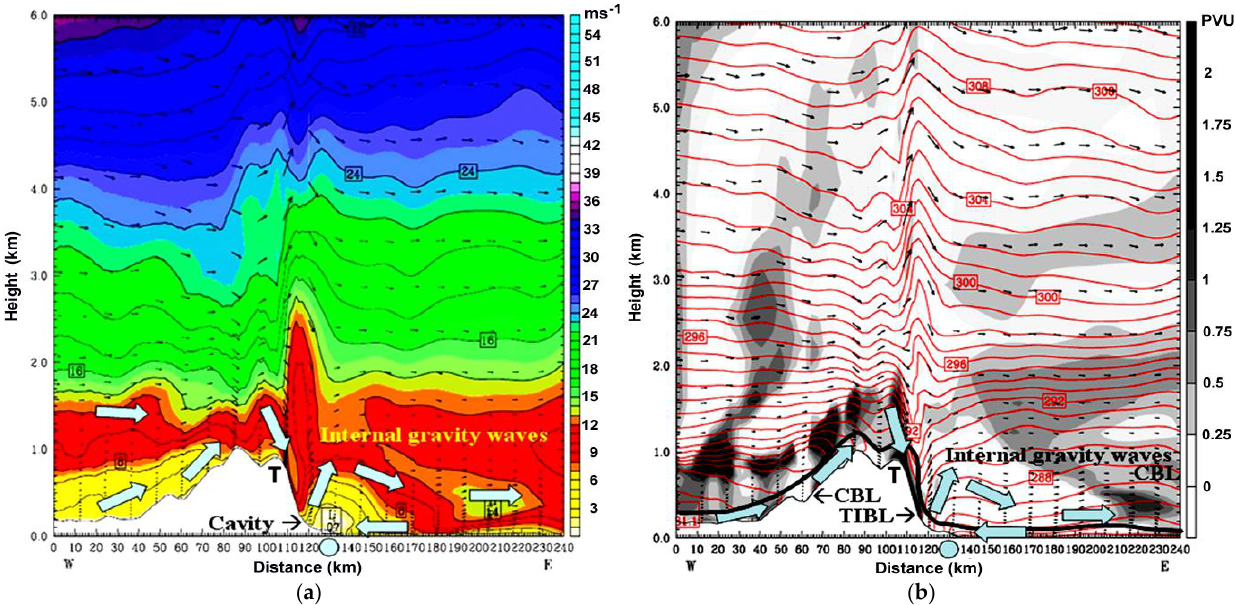
Figure 14 . Vertical profile of ( a ) horizontal wind (m/s) and ( b ) potential temperature (k) and wind speed (m/s) simulated by WRF model at ( a ) 09:00 LST, 30 March 2004. Tick line, CBL, TIBL, T, and a small circle on the bottom of the figures denote the top of convective boundary layer, convective boundary layer, thermal internal boundary layer and Gangneung city, respectively. The dust transporting from the Nei-Mongo toward the Korean east coast moved down along the eastern slope of the mountain inside the TIBL and combined with pollutants emitted from the city. They were trapped inside a small calm cavity in ( a ) by the confront of IGW and easterly wind,